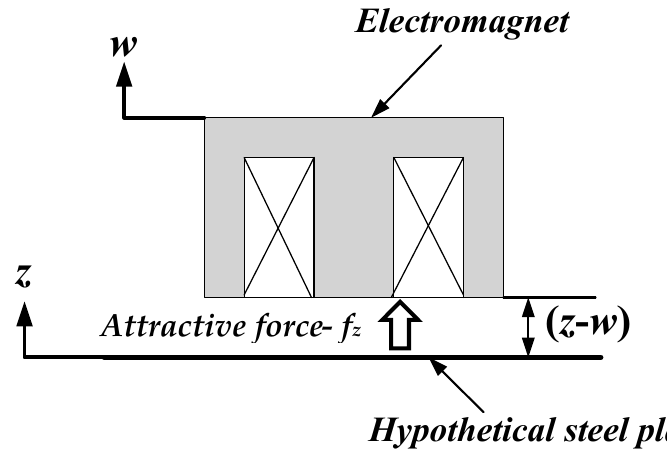
Figure 7. One degree-of-freedom model of levitation control of the steel plate.